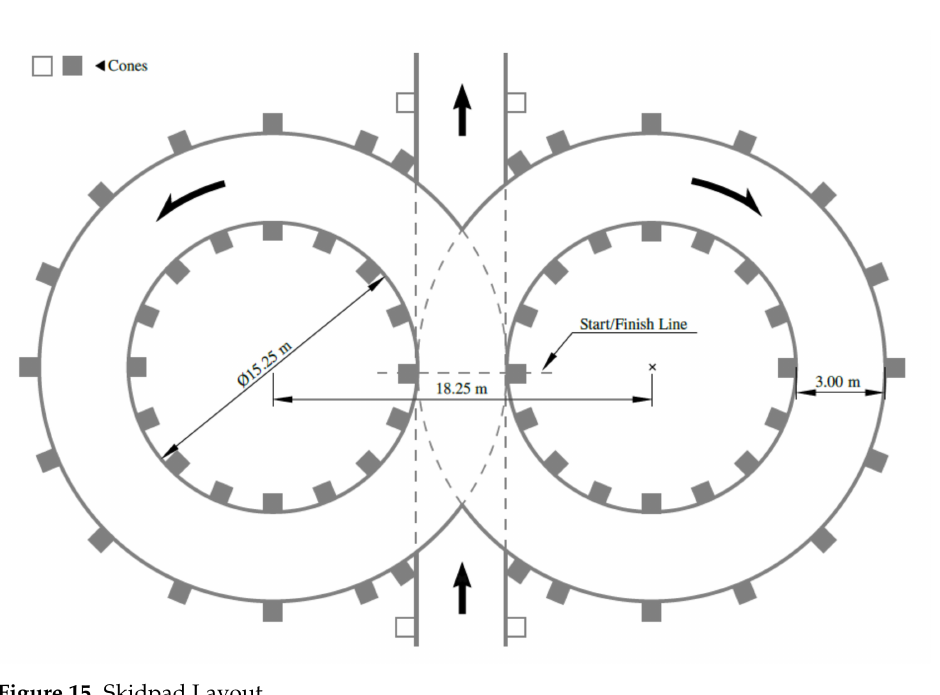
Figure 15. Skidpad Layout.